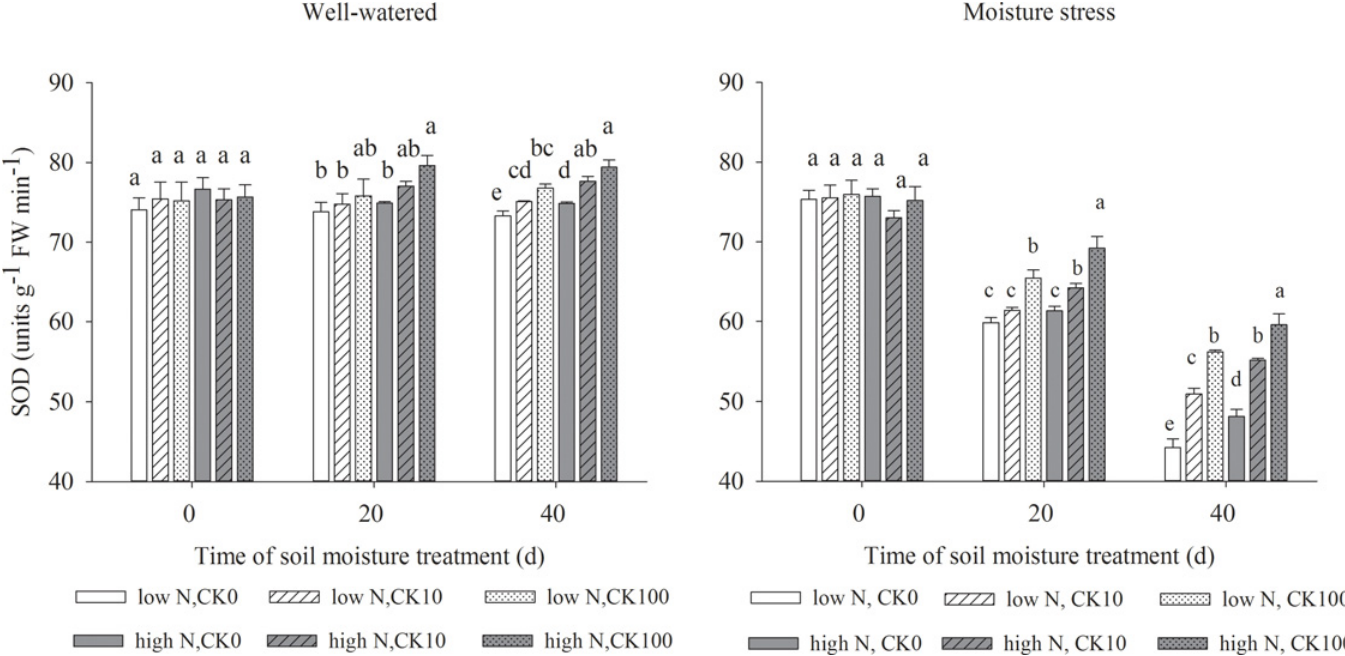
Fig 2. Activities of superoxide dismutase (SOD) in leaves of drought stressed creeping bentgrass as affected by cytokinin trans -zeatin riboside (CK) and nitrogen. Bars having different letter indicate no significant enzyme activity difference (P < 0.05) between treatments on the same day.